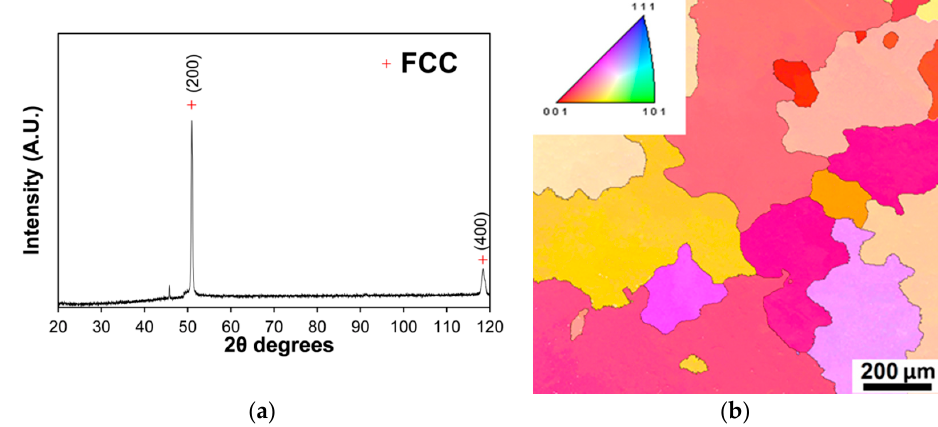
Figure 1. Structure of the Al-, C-containing CoCrFeNiMn-type alloy in the as-cast condition: ( a ) XRD pattern; and ( b ) EBSD IPF map. Table 1. Chemical composition of the Al-, C-containing CoCrFeNiMn-type alloy. Concentration Al